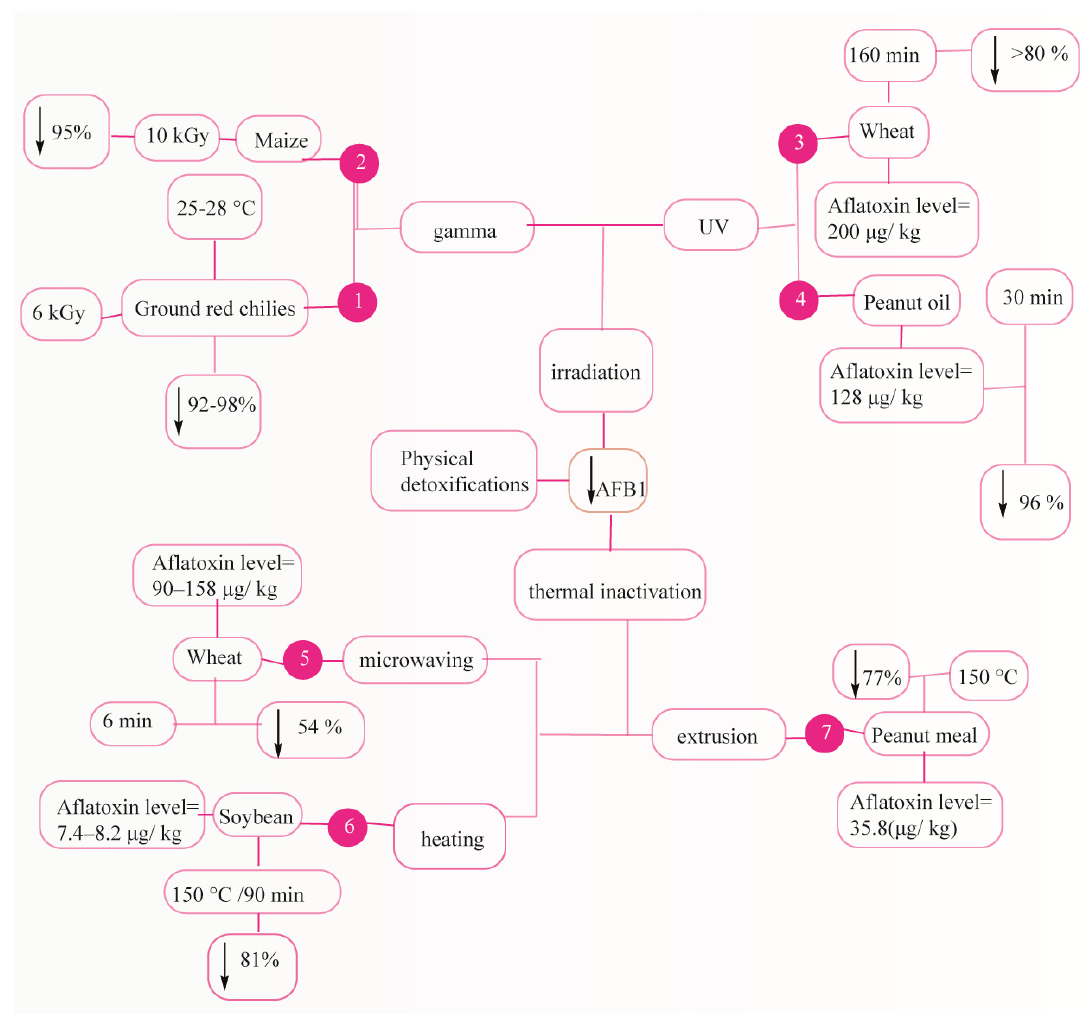
Figure 4. Overview of physical detoxification methods. (1, [179]), (2, [180]), (3, [181]), (4, [182]), (5, [183]), (6, [171]), (7,